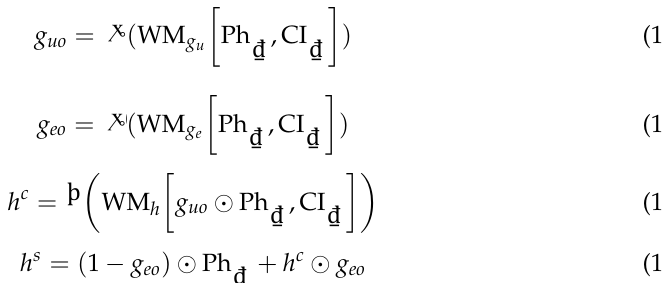
Figure 3. The overall architecture of the dynamic UAV approach.